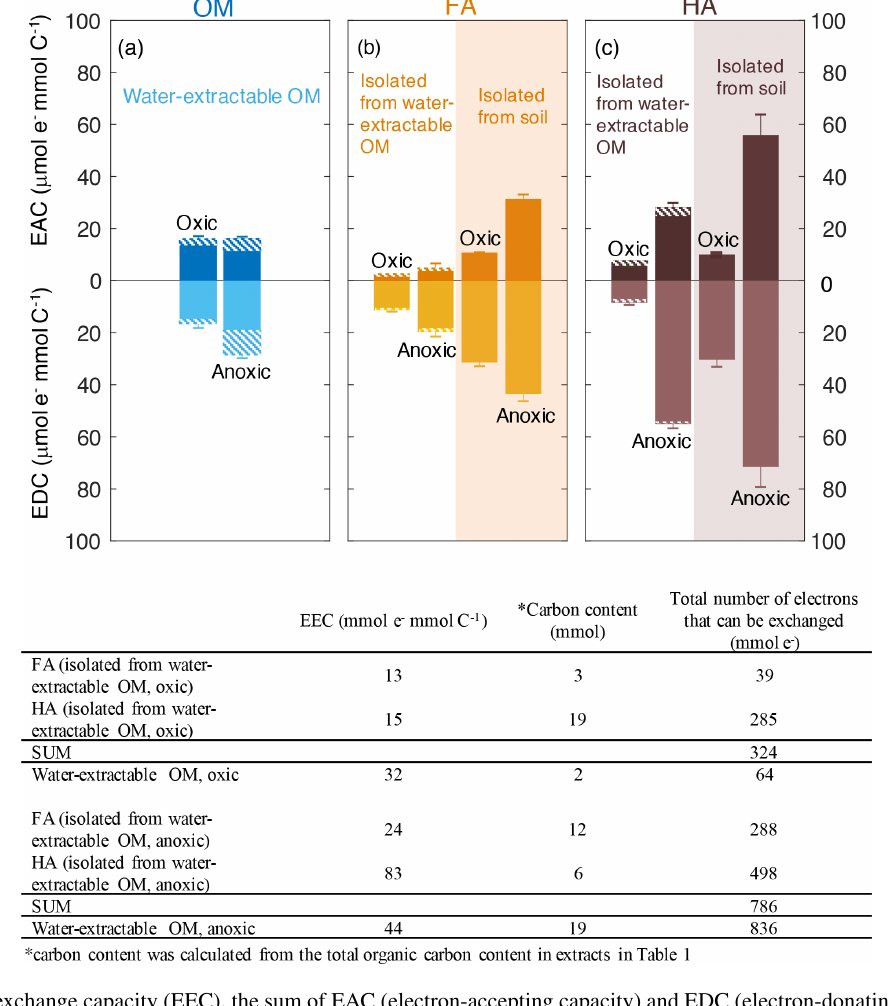
Figure 3. Electron-exchange capacity (EEC), the sum of EAC (electron-accepting capacity) and EDC (electron-donating capacity) of water- extractable OM (a) , FA (b) , and HA (c) extracted from Schönbuch forest soil under oxic or anoxic conditions. Areas with white background represent FA and HA isolated from water-extractable OM, whereas orange and purple shaded areas represent FA and HA isolated from soil, respectively. Hashed areas represent the EAC or EDC contribution stemming from redox-active Fe(III) and Fe(II) ions in the samples. The integrated current response was normalized to the DOC of all extracts. Despite the contribution of Fe to the redox activity, we decided to normalize the EAC and EDC values to C content because in most cases the Fe contribution was small and because normalizing the EAC and EDC values to total weight of material would be misleading since the fraction of inorganic, non-redox active constituents (e.g., Mg 2 + , Ca 2 + ions from salts present in the soil) varies significantly between the different extracts (Table S5). Error bars indicate the standard deviations of at least four replicates. Two-way ANOVA statistical analysis was conducted and the result suggested the measured EEC values of the extracts were significantly different from each other ( P < 0 . 005, Table S4). The table underneath the figure shows the recovery of total number of electrons that can be exchanged (that means transferred from Fe(III)-reducing bacteria to the OM, or from the OM to Fe(III) minerals) by water-extractable OM before and after the chemical isolation of HA and